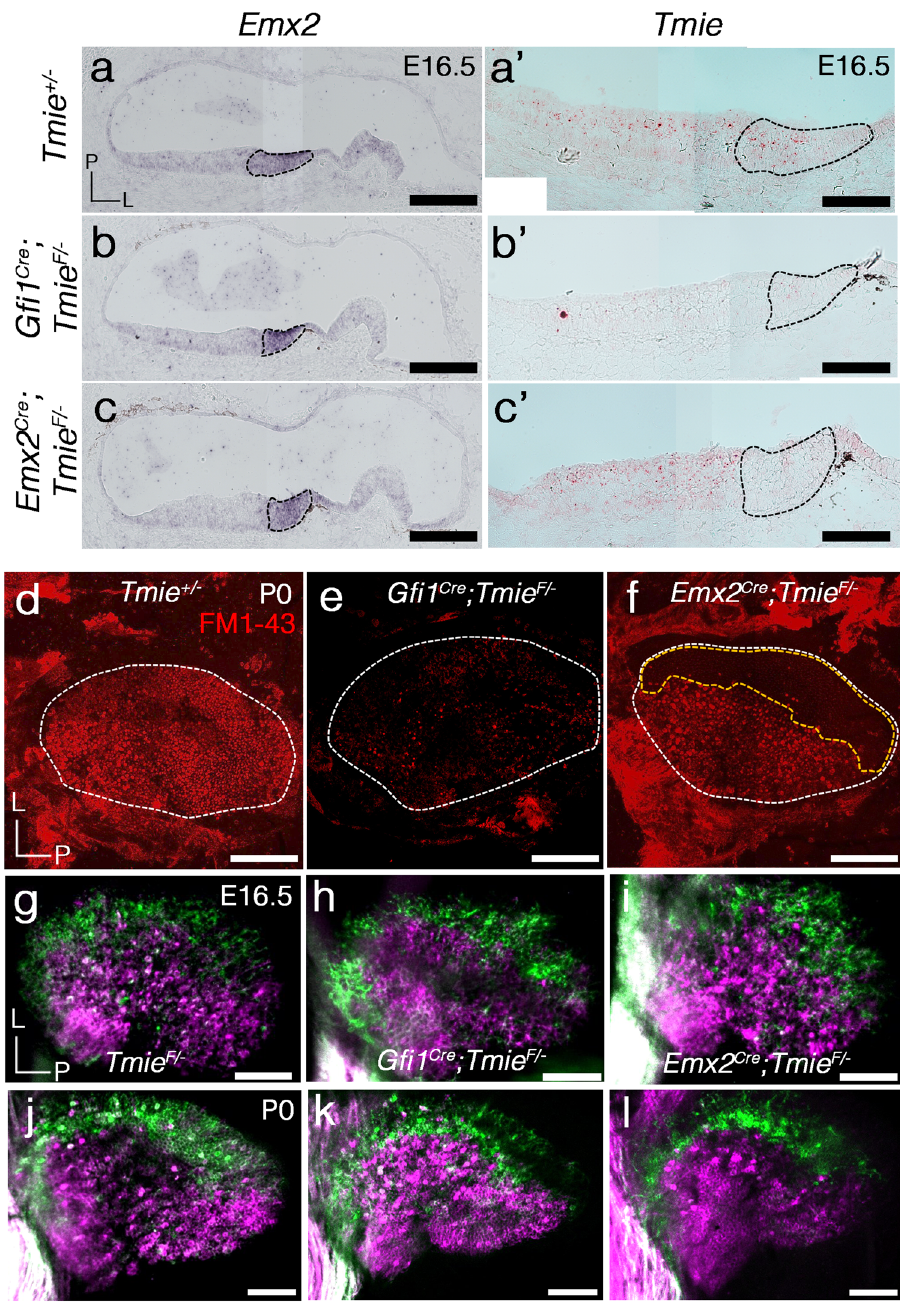
Fig. 6 | Loss of mechanotransduction in HCs of Tmie cKO utricles does not affect its neuronal segregation pattern. a – c ’ Emx2 ( a – c ) and Tmie ( a ’ – c ’ ) tran- scripts in sections of Tmie +/ − ( a , a ’ , n =3), G fi 1 cre ; Tmie F/ − ( b , b ’ , n =2), and Emx2 cre ; Tmie F/ − ( Tmie cKO, c , c ’ , n =3) utricles. Tmie transcripts are absent in the entire sensory epithelium of G fi 1 cre ; Tmie F/ − utricle ( b ’ ) but are absent only in the Emx2-positive lateral region ( a – c , black dotted region) of Emx2 cre ; Tmie F/ − utricles ( c ’ ). d – f FM1-43 staining in live utricles of Tmie +/ − ( d , n =5), G fi 1 cre ; Tmie F/ − ( e , n =3), and Emx2 cre ;Tmie F/ − ( f , n =4)innerearsatP0.FM1-43ispresentintheentiresensory epithelium of Tmie +/ − ( d ), absent in G fi 1 cre ; Tmie F/ − ( e ) and absent only in the lateral